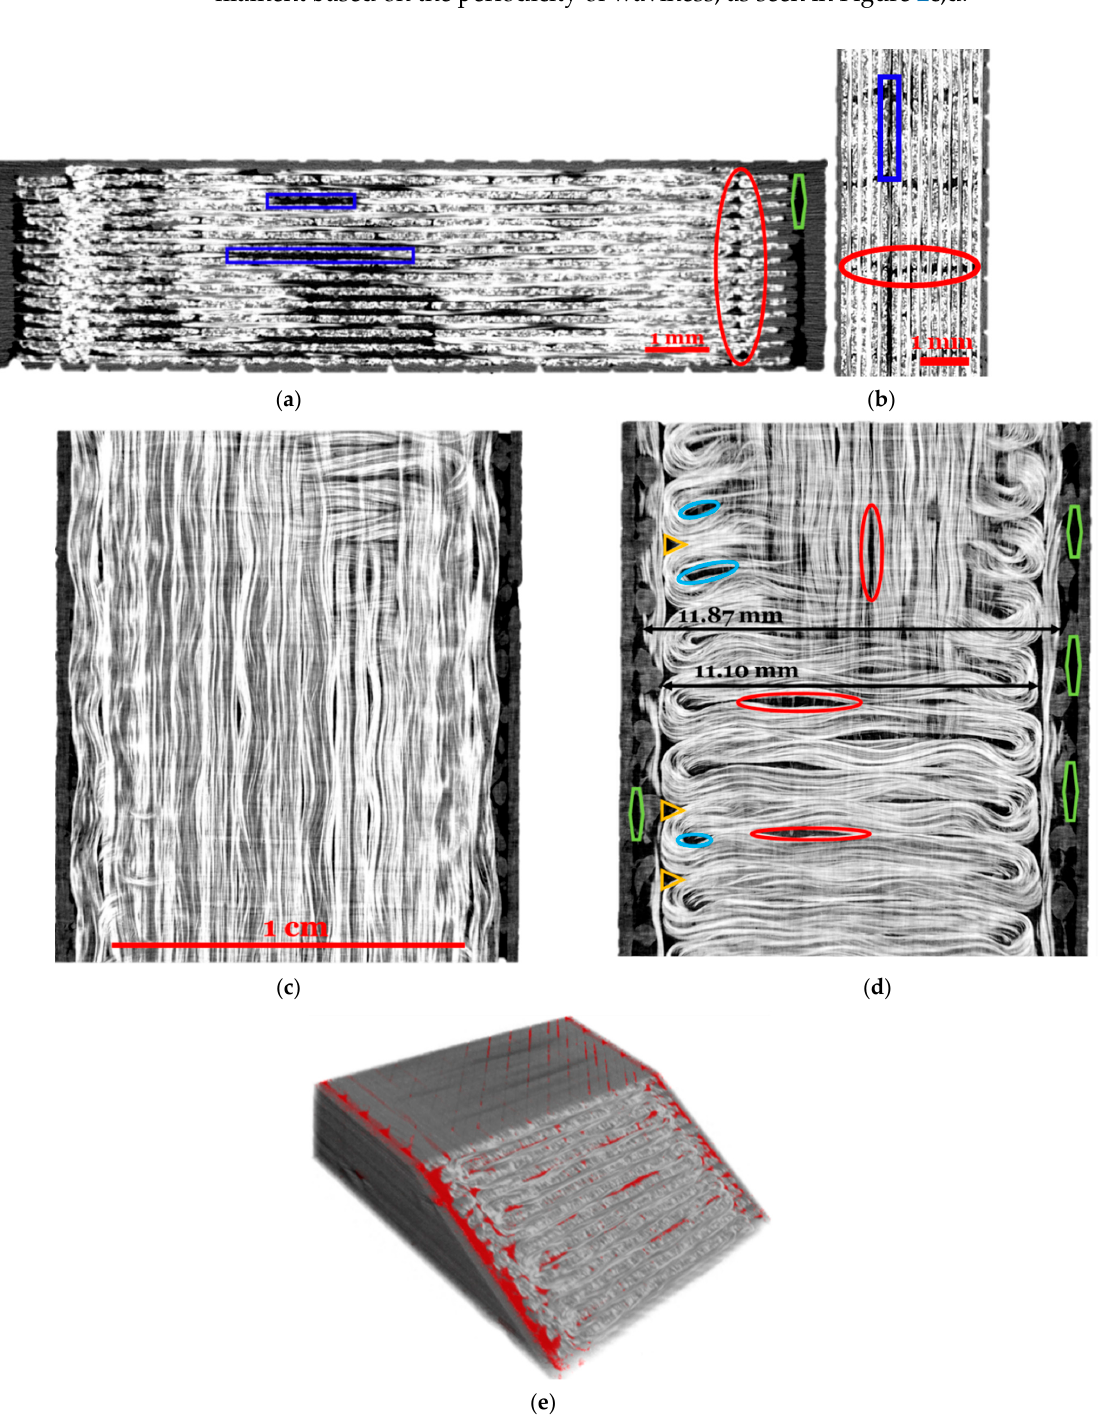
Figure 2. Different X-ray tomography images of an Izod 0/90 specimen showing the internal structure including fiber, polymer and void shape and distribution. The cross-sectional ( a ) and longitudinal ( b ) views present the stacking of layers, ( c , d ) exhibiting slices of 0° and 90° orientated layers, finally ( e ) is 3D image of the composite.